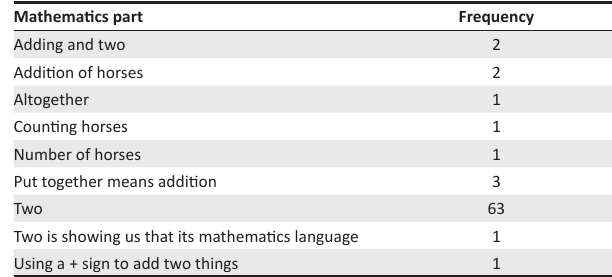
TABLE 1: Is there mathematics in the excerpt?